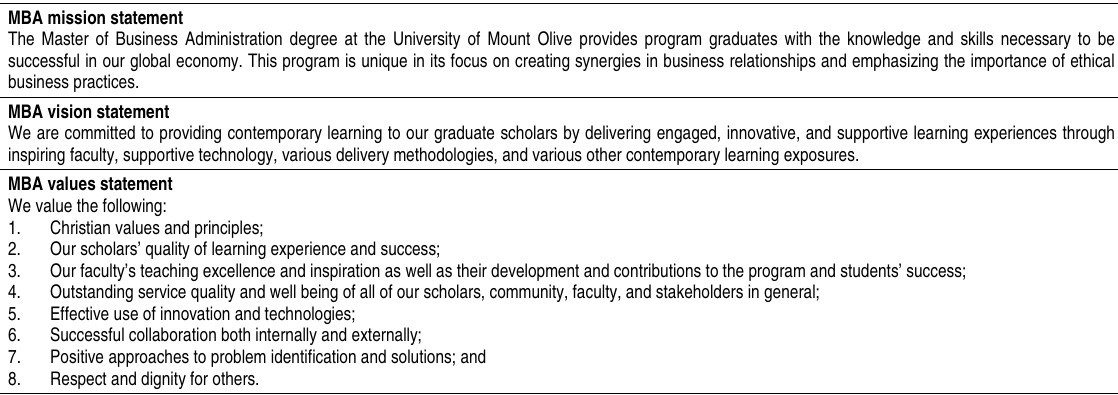
Table 2. MBA mission statement, vision statement, and values statement, University of Mount Olive (as